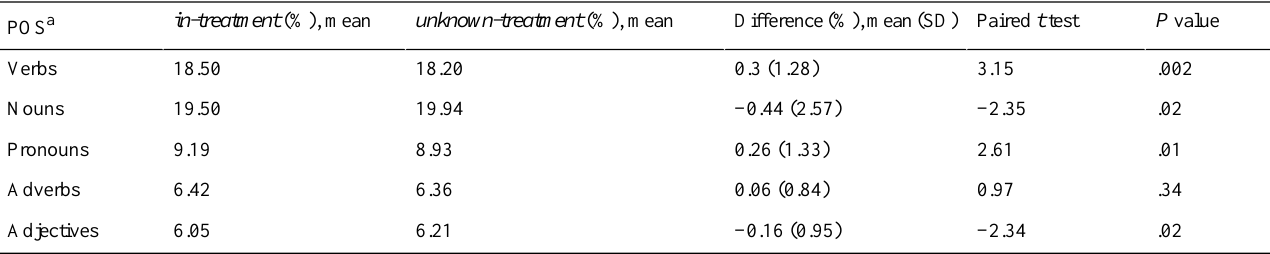
Table 4. Percentages of part-of-speech words compared between in-treatment and unknown-treatment